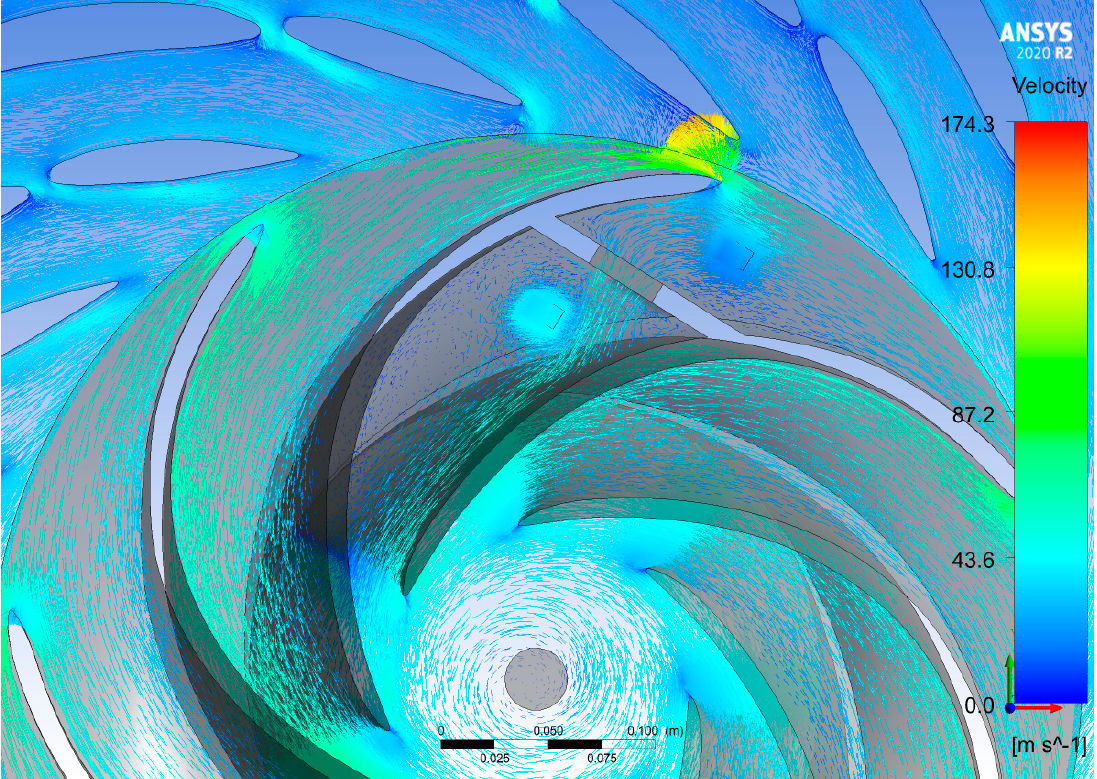
Figure 11. Relative velocity vector plot near the blockage for a 25% obstructed rotor.